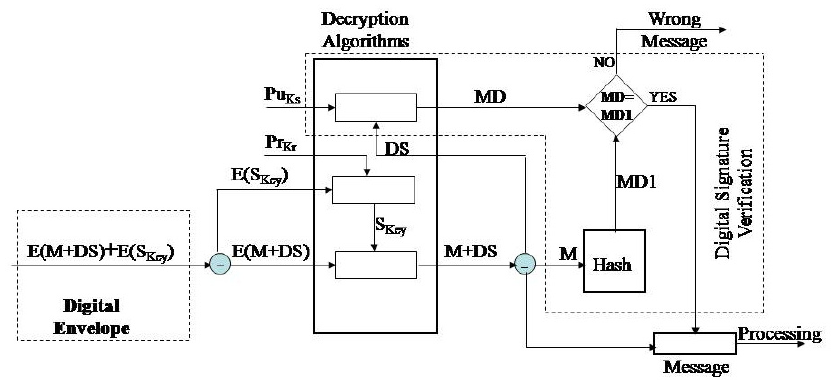
Figure 3. Detailed overview of the message verification phase.